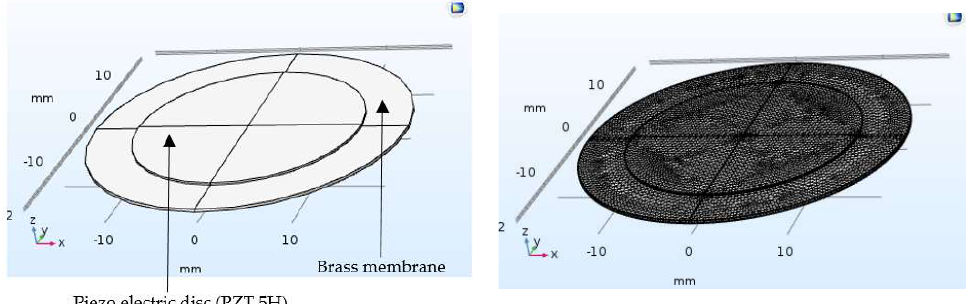
Figure 3. Designed and meshed models of the PZT actuated diaphragm.